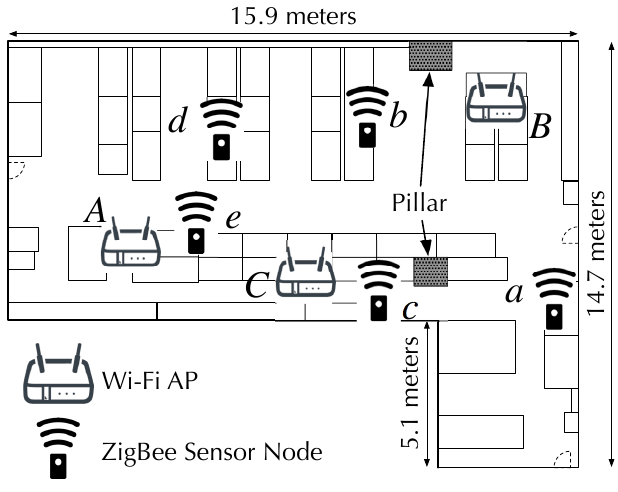
Figure 6. Experiment environment in our